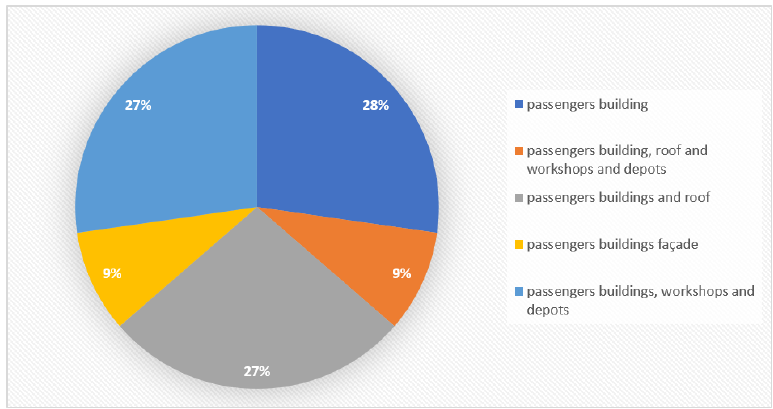
Figure 14. Permanencies. Own elaboration.